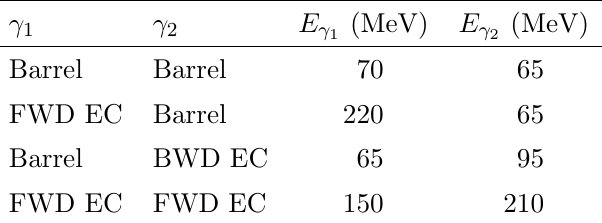
Table 3 . Optimized E (cid:13) thresholds for the photon candidates. The FWD EC, barrel, and BWD EC regions of the ECL are de(cid:12)ned in the polar angle ranges (12.4 (cid:14) , 31.4 (cid:14) ), (32.2 (cid:14) , 128.7 (cid:14) ), and (130.7 (cid:14) , 155.1 (cid:14) ), respectively.